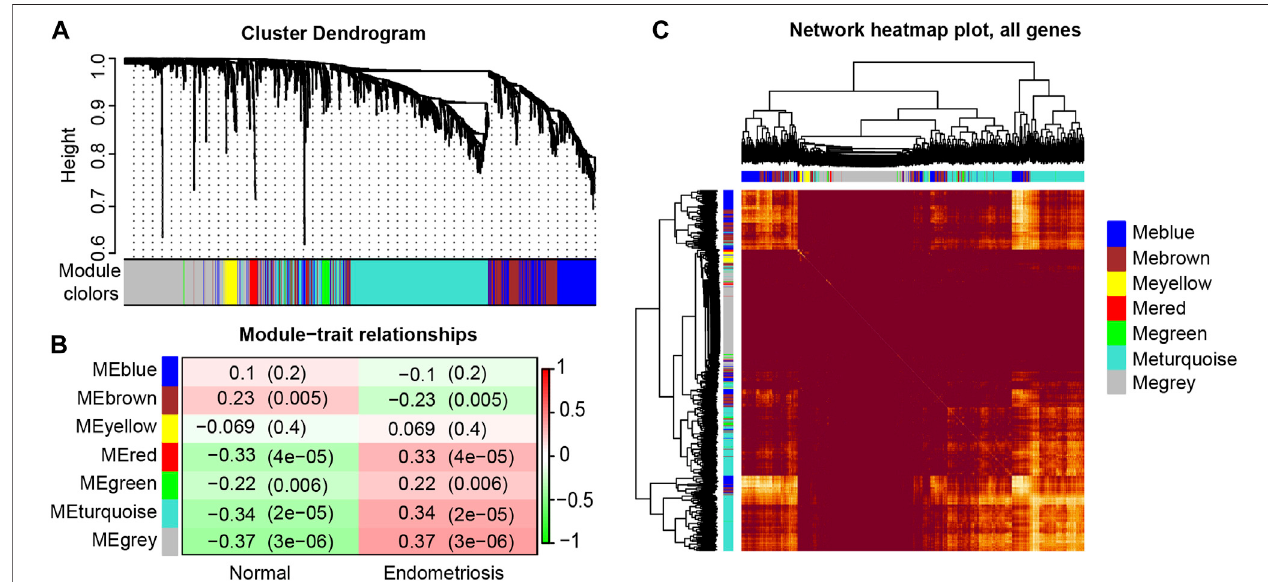
FIGURE 1 | Identi fi cation and characterization of endometriosis-associated autophagy-related genes (ATGs) key modules. Hierarchical cluster tree showing co- expression modules based on WGCNA (A) . Correlation between seven key modules and clinical traits (B) . Co-expression heat map and correlations for ATGs in models (C)